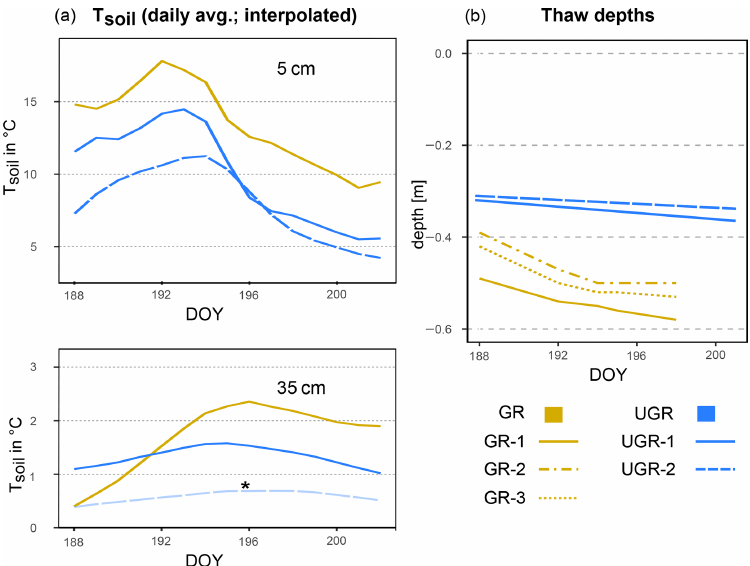
Figure 1. (a) Soil temperature ( T soil ) at GR, UGR-1 and UGR-2 at 5 and 35cm depth. The interpolation model of T soil at 35cm at UGR-2 (*) is not based on a significant fit but follows the expected course closely and is therefore included here for overview. (b) Evolution of thaw depths at all